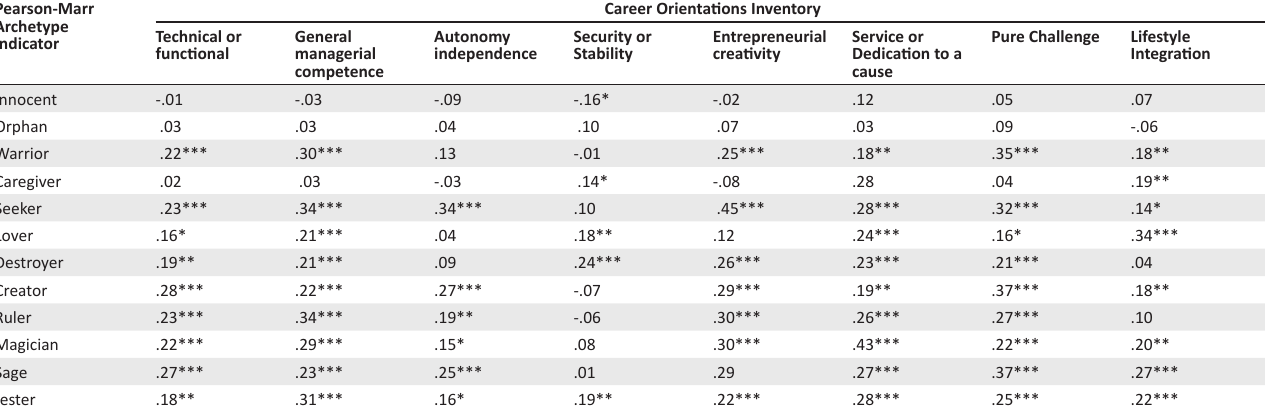
TABLE 4: Significant correlations between PMAI and COI variables ( N = 207). Pearson-Marr Archetype